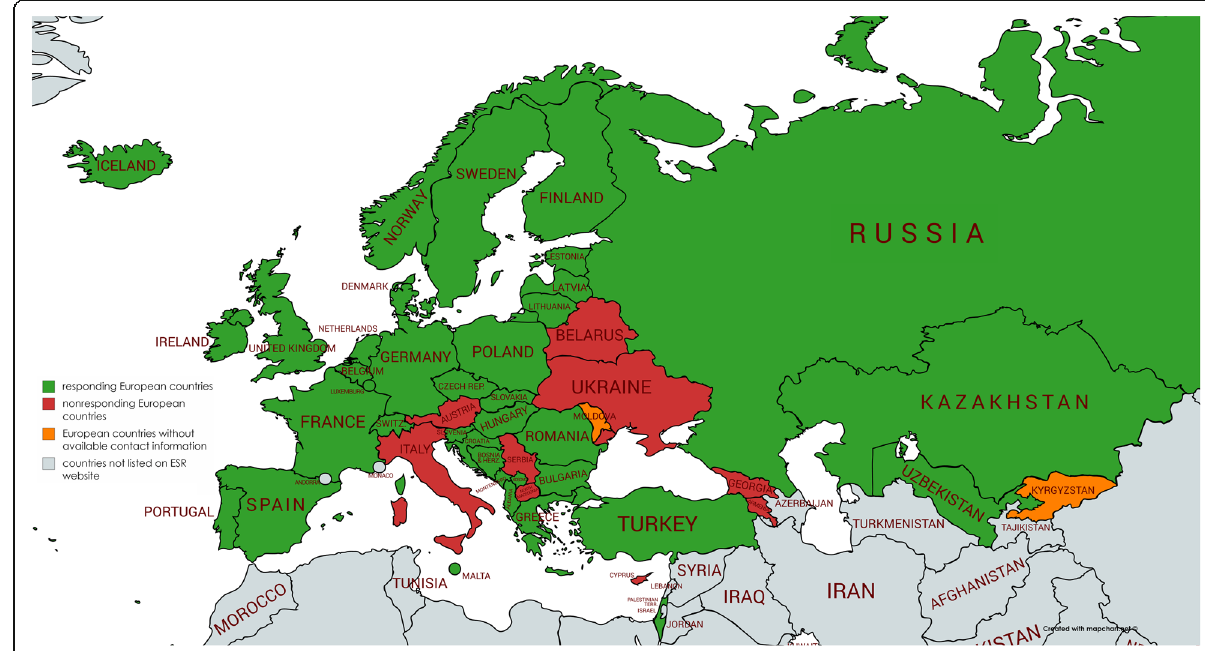
Fig. 1 Overview of responding European countries, non-responding European countries, and European countries without available contact